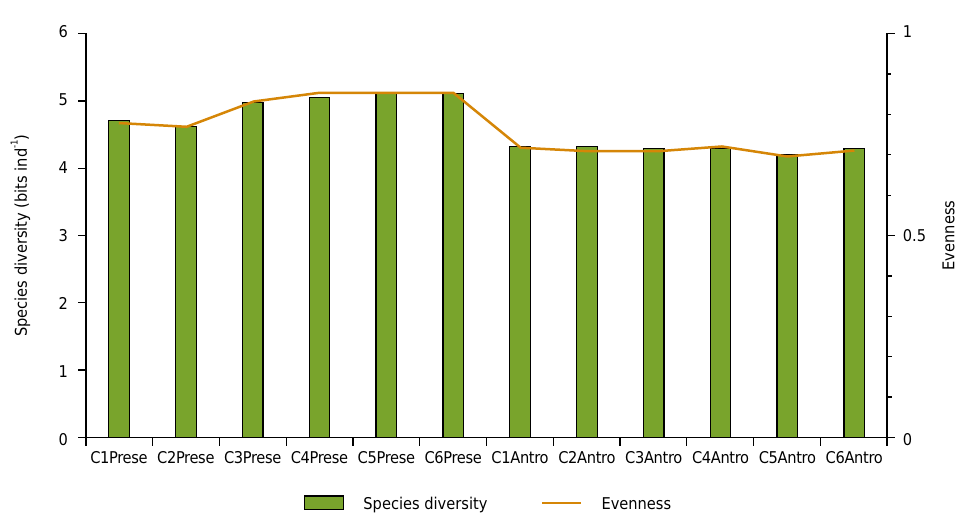
Figure 1. Diversity (bits per ind) of the species of filamentous fungi in the preserved area (Prese) in the anthropic area (Antro), in six sample collections (C1, C2, C3, C4, C5, and C6); and Evenness statistical analysis based on the Shannon index. C1: collection 1; C2: collection 2; C3: collection 3; C4: collection 4; C5: collection 5; C6: collection